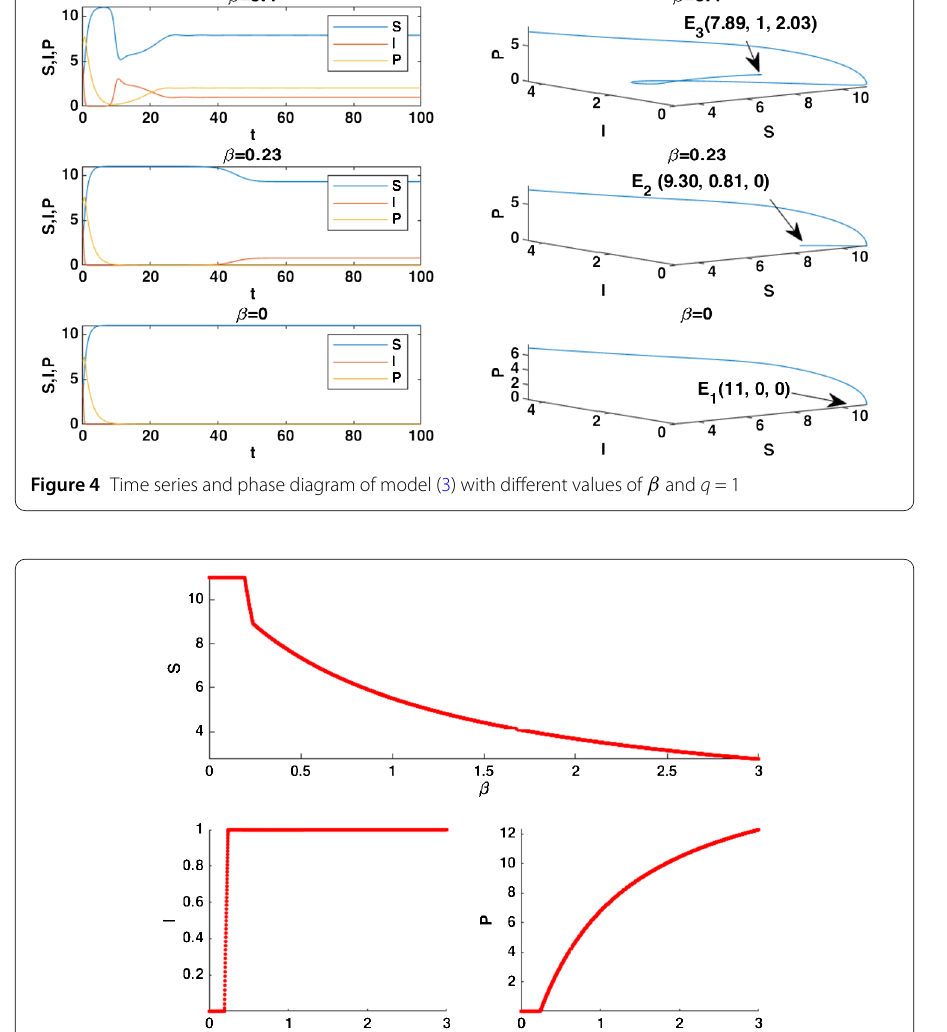
To depict the impact of prey’s disease ( β ) on the dynamics of the fractional-order eco- epidemiological model (3) (when q = 0.9) the bifurcation diagram is depicted in Fig. 3 with respect to β . The transcritical bifurcation value localized at β tr = 0.240449 is